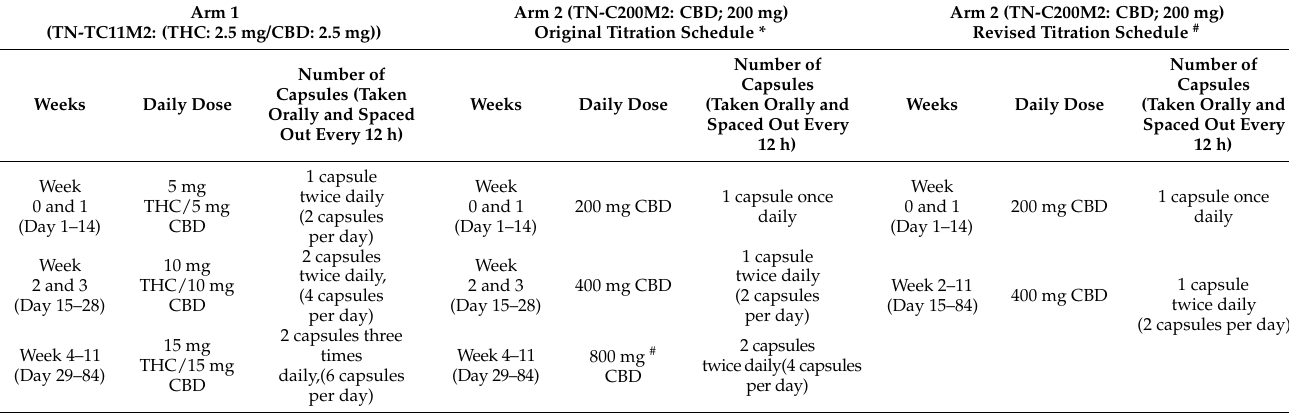
Table 1. Recommended up-titration schedule for TN-TC11M2 and TN-C200M2